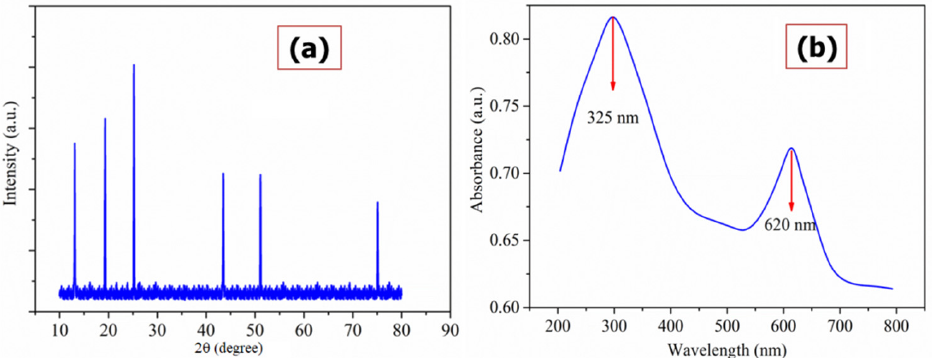
Figure 2 . ( a ) Powdered XRD patterns and UV-Vis ( b ) spectroscopic analysis of the Cu(I)-PANI com-